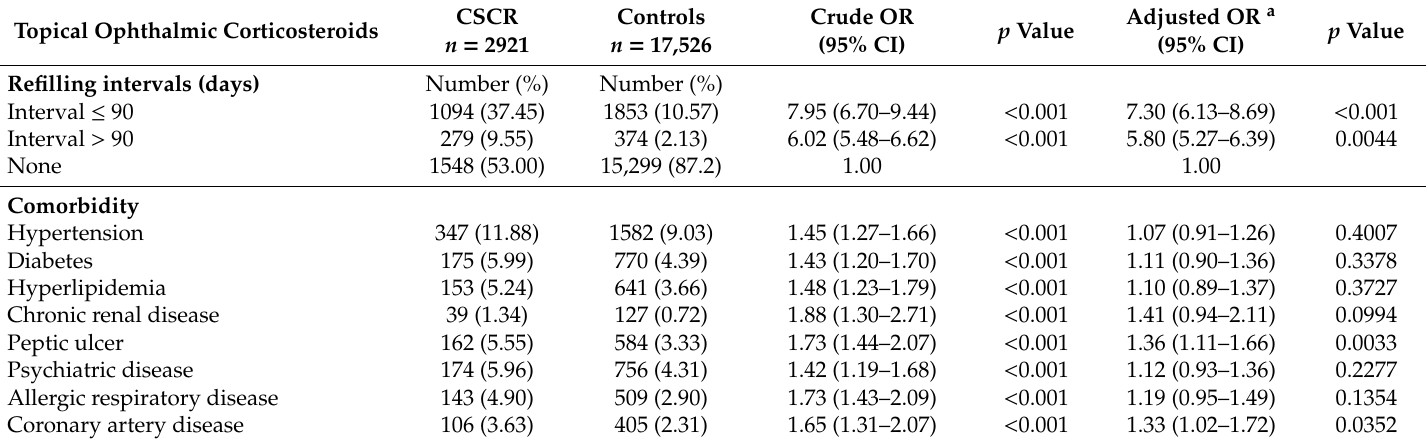
Table 3. OR obtained by univariate and multivariate logistic regression for various prescription durations of topical ophthalmic corticosteroids use between CSCR patients and